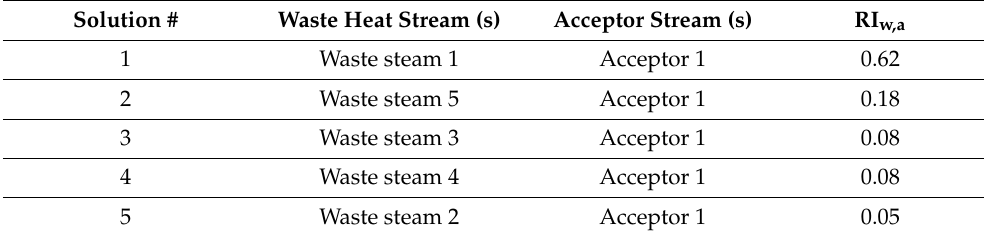
Table 6. Ranking of the waste heat and acceptor stream based on RI w,a .